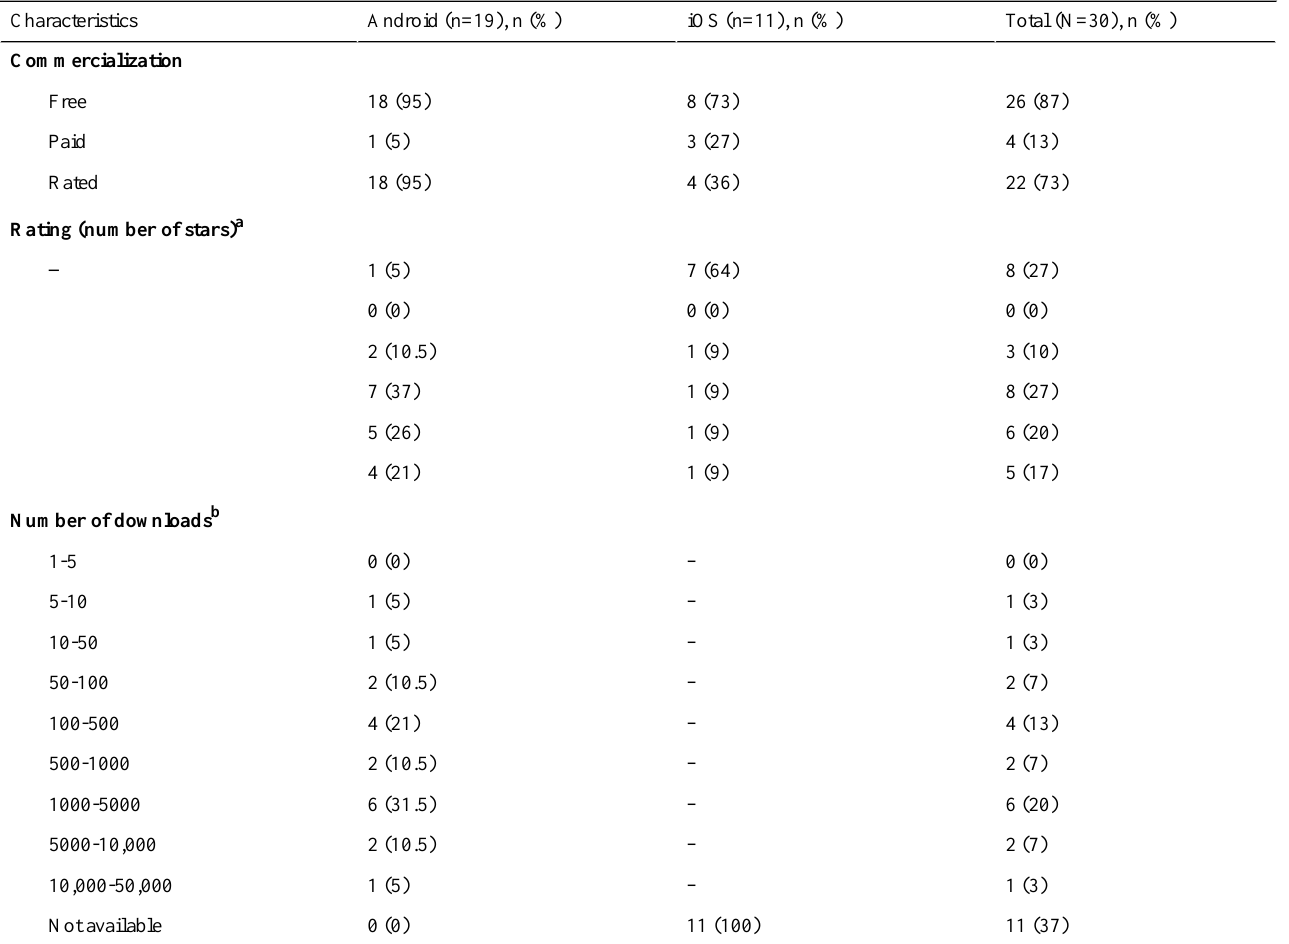
Table 2. General characteristics